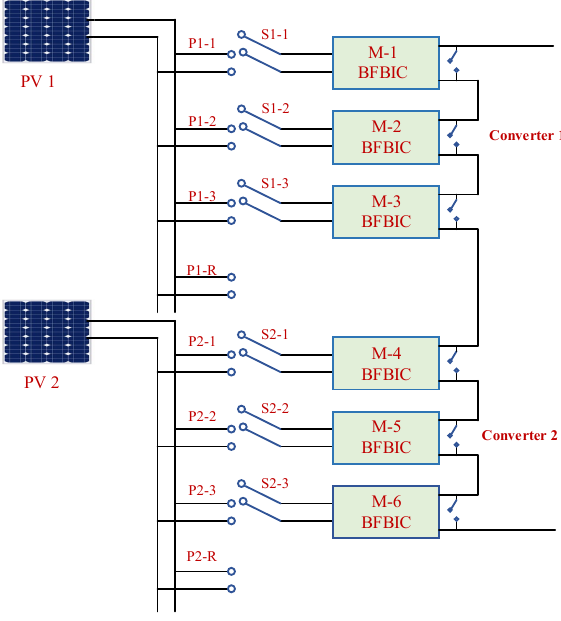
Figure 7. Connection structure of the combination converter.